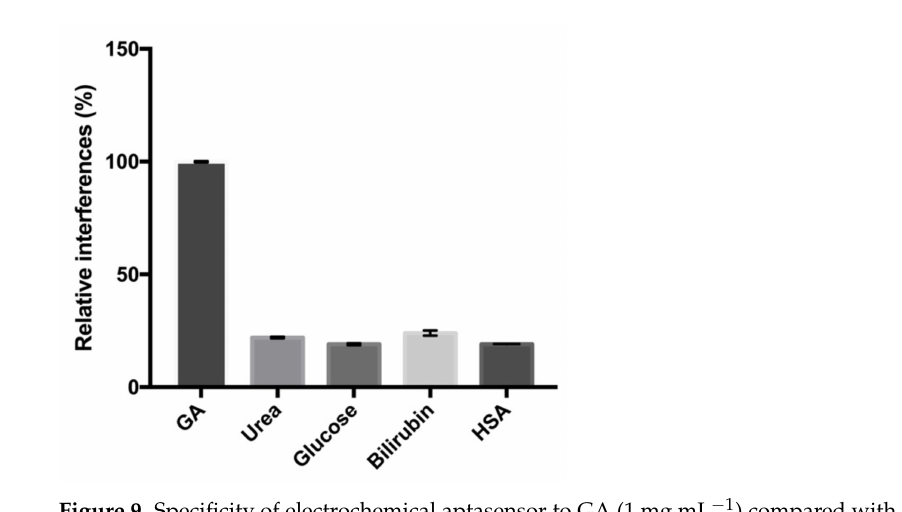
Figure 9. Specificity of electrochemical aptasensor to GA (1 mg mL − 1 ) compared with other biomate- rials urea (2.5 mg mL − 1 ), glucose (125 mg dL − 1 ), bilirubin (2 mg dL − 1), and HSA (100 µ g mL − 1 ).